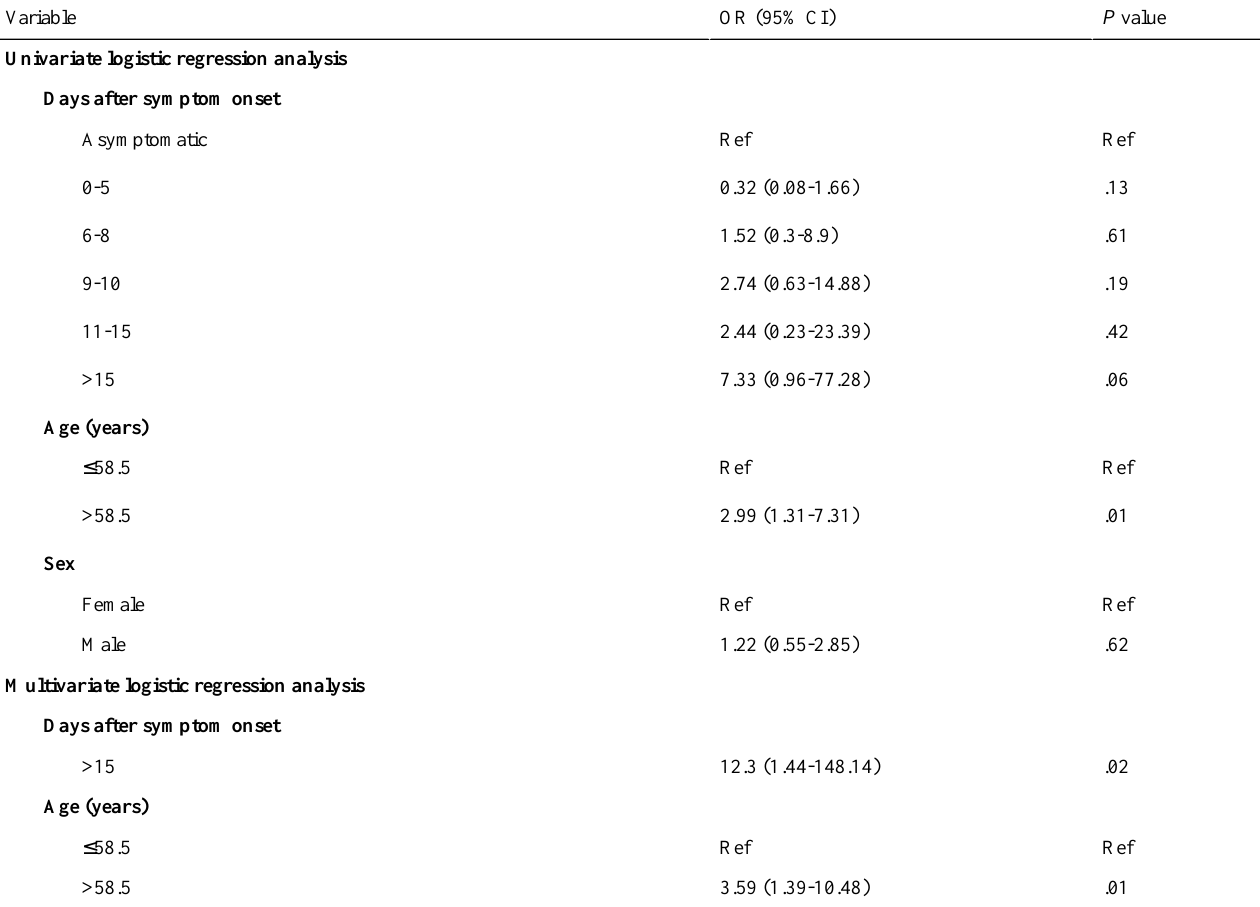
P valueOR (95% CI)Variable